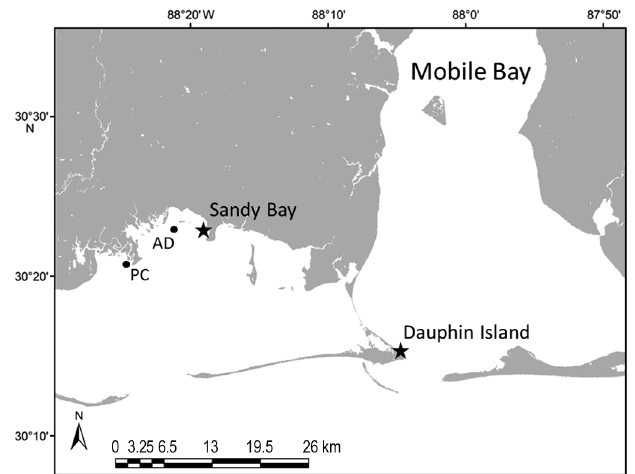
Fig. 1. Mobile Bay estuary, Alabama, USA, with Dauphin Island and Sandy Bay study sites (stars) where oysters were deployed. Water salinity and temperature recorders were located at the Dauphin Island Sea Lab station located ~150 m from our Dauphin Island study site, and at (black dots) Point Aux Chenes (PC) and Alabama Department of Public Health station 176